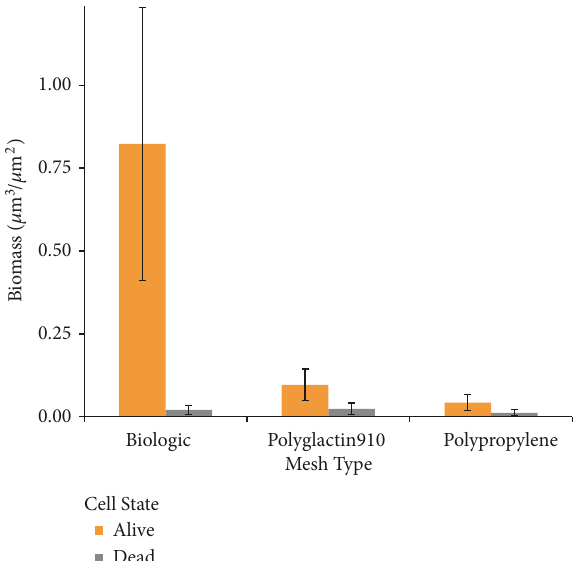
Figure 2: Average Biomass after 24hr Exposure to MRSA . Quantification of biofilm biomass, orange bars represent viable bacteria and light grey bars nonviable bacteria.